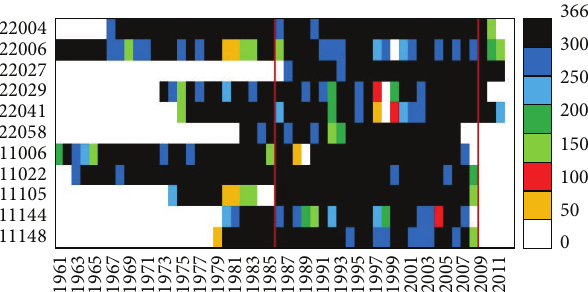
Figure 2: Data pattern of the available number of maximum and minimumdailytemperaturedatesperyearfortheemployedweather